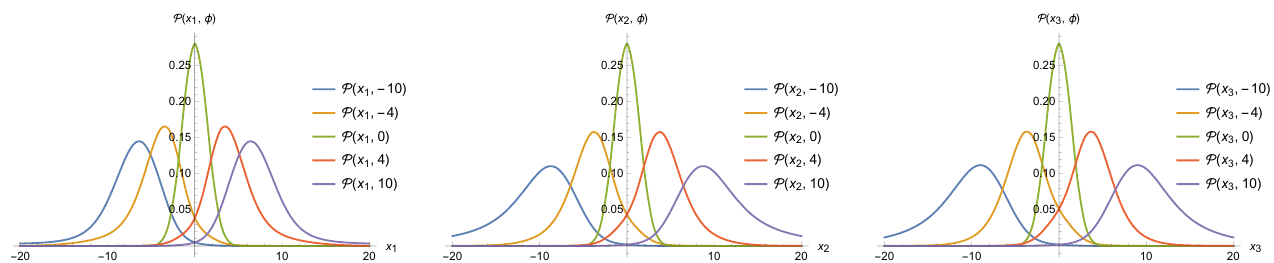
Figure 8. The normalized sections P ( x i , φ ) are shown in sequence for i = 1,2,3 respectively at different times. Their spreading behavior over time is evident together with the Gaussian-like shape.